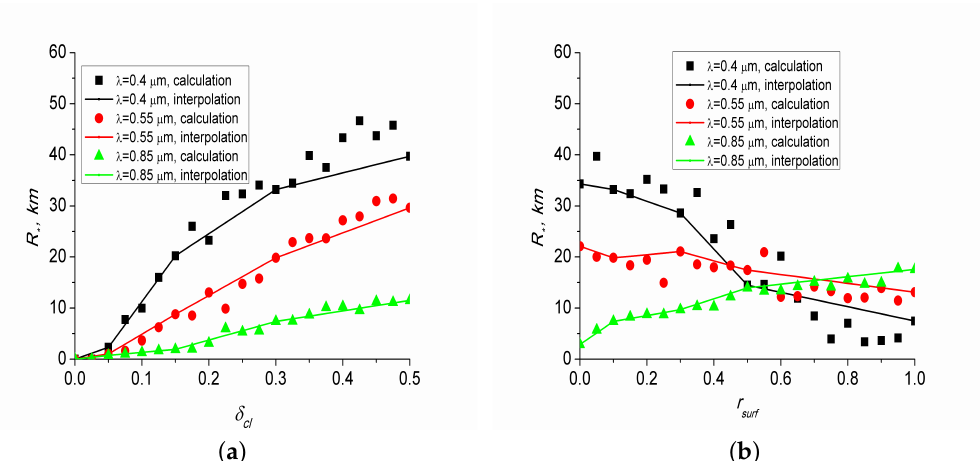
Figure 4. Results of comparison of the calculated R ∗ values and interpolated using Formula (12): ( a ) τ 0.55 = 0.09, ∆ h = 1.5 km, θ sun = θ d = 45 ◦ , ϕ = 0 ◦ , σ cl = 20 km − 1 , and r surf = 0.1; ( b ) τ 0.55 = 0.09,